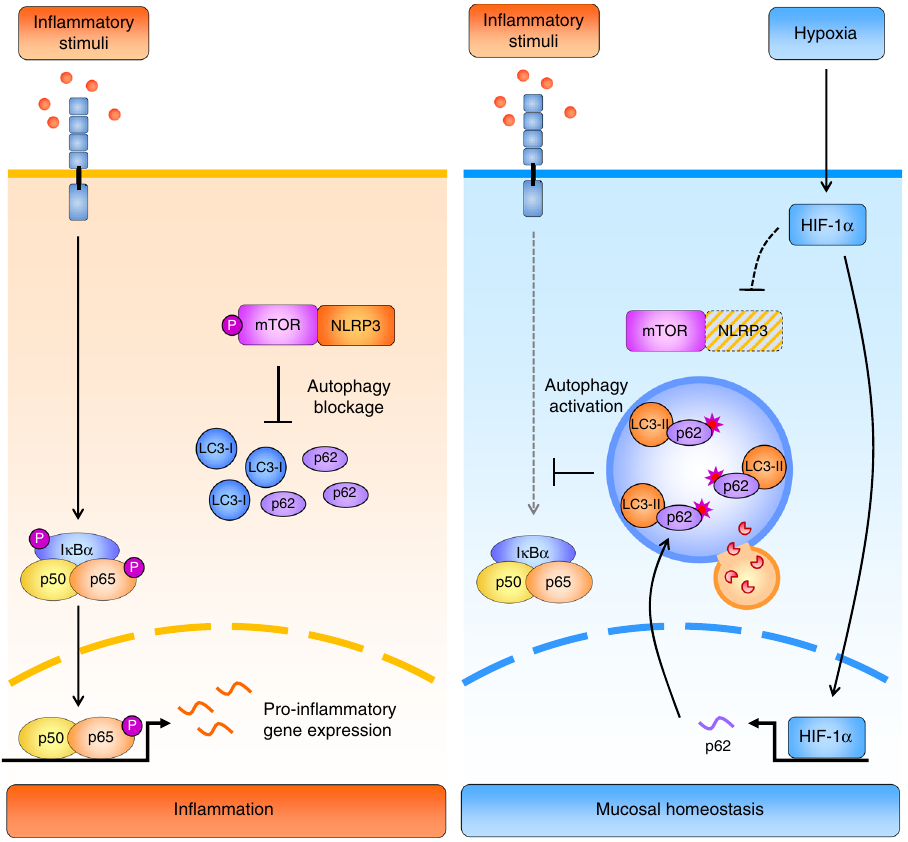
Fig. 8 Hypoxia ameliorates in fl ammation through the activation of autophagy via downregulation of NLRP3/mTOR. Under conditions of in fl ammation, NLRP3 directly binds and promotes the phosphorylation/activation of the autophagy inhibitor mTOR, thereby blocking autophagy. As a result, autophagosomal clearance of pro-in fl ammatory mediators is impaired, leading to the perpetuation of in fl ammation. Hypoxia-mediated HIF-1 α accumulation induces the expression of p62, and the reduction of NLRP3 protein levels, thereby downregulating mTOR phosphorylation. Subsequent autophagy activation leads to autophagosomal degradation of pro-in fl ammatory mediators upstream of the NF- κ B signalling cascade, leading to reduced proin fl ammatory gene